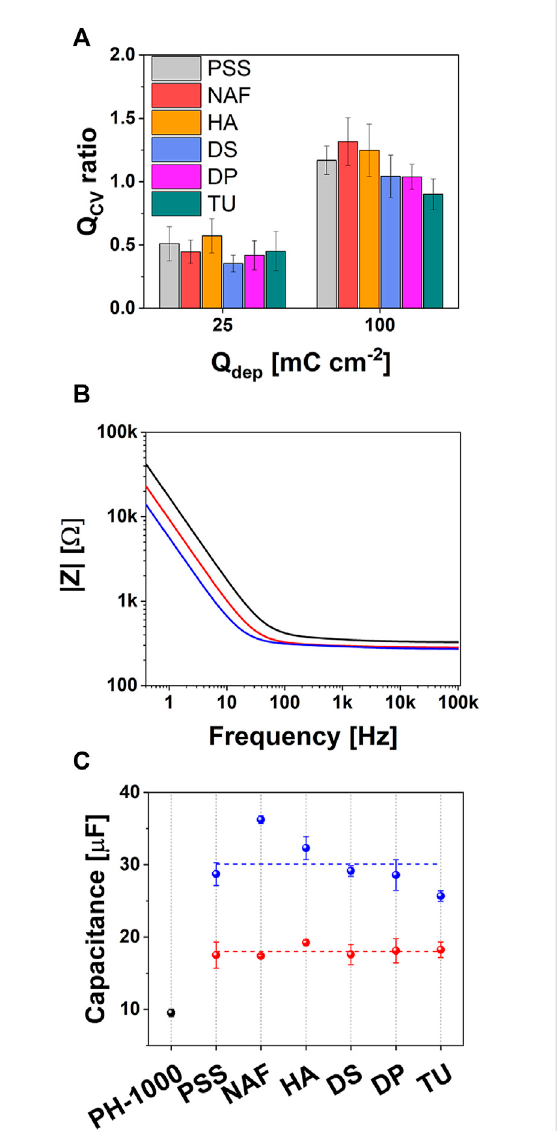
FIGURE 2 (A) Q ratio values obtained from CV analysis (see the text for details); (B) representative Bode plot showing the impedence |Z| for fi lms of PH-1000 (black), PEDOT/X at Q dep = 25 mC cm − 2 (red) and Q dep = 100 mC cm − 2 (blue), respectively; (C) variation of capacitance values at Q dep = 25 mC cm − 2 (red) and Q dep = 100 mC cm − 2 (blue), compared to PH-1000